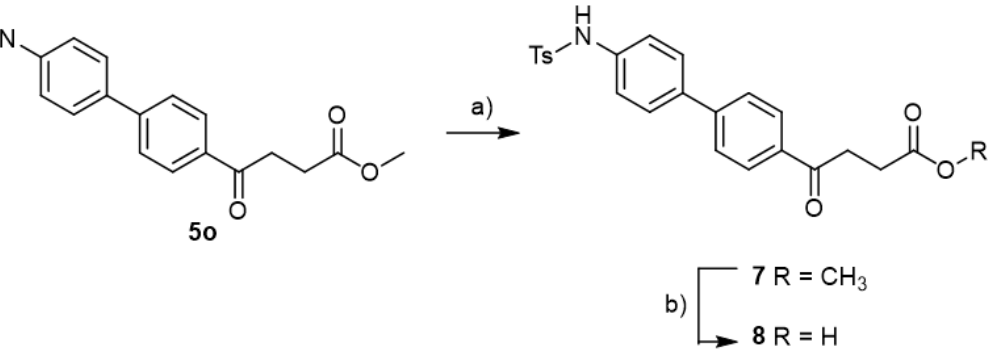
Scheme 2. Preparation of fenbufen sulfonamide. ( a ) TsCl, pyridine, CH 2 Cl 2 0 ◦ C to r.t., 16 h, 48%, ( b ) LiOH, THF/H 2 O = 3:1, r.t., 1.5 h,